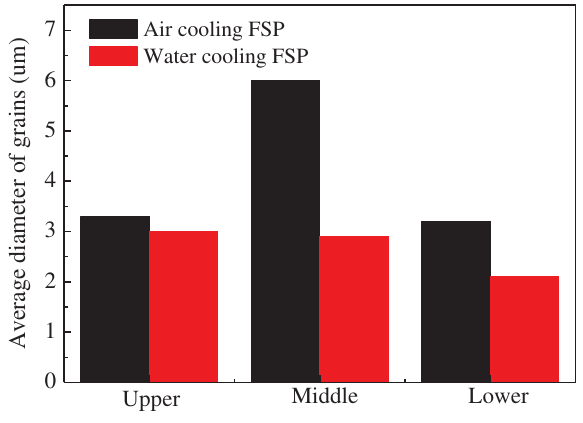
Figure 5: Average sizes of the SZ